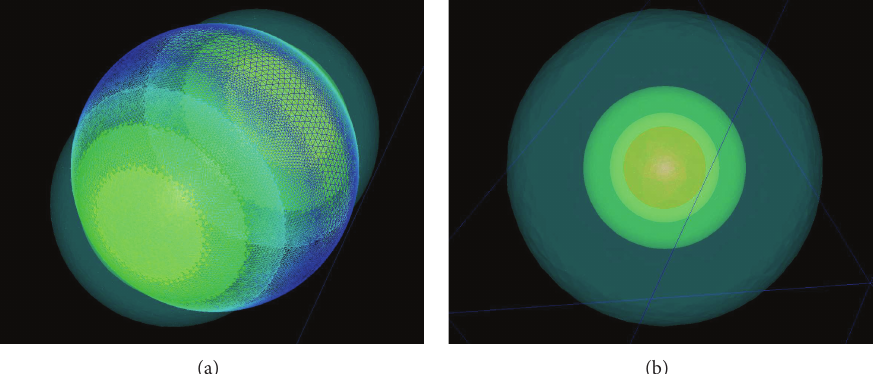
Figure 11: Isosurfaces of the intensity of electric field (a) and temperature (b), after adaptive remeshing with 𝐴 3 strategy ( 𝑁 5 = 2586 902 elements).